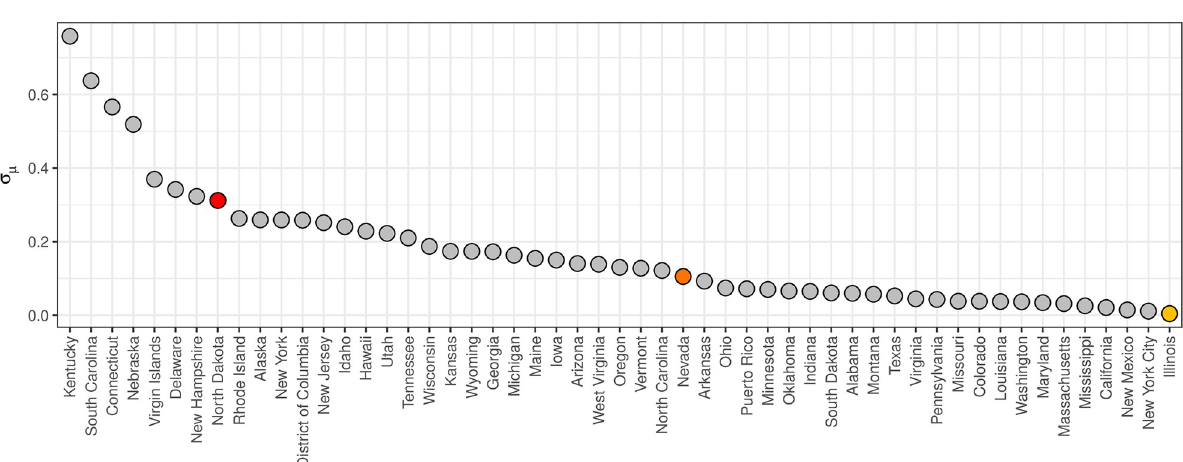
across states is observed. m